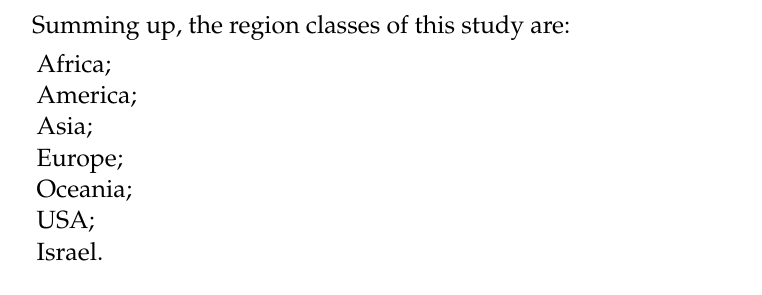
Figure 2. Percentage of UAV database entries per region (out of 202 total